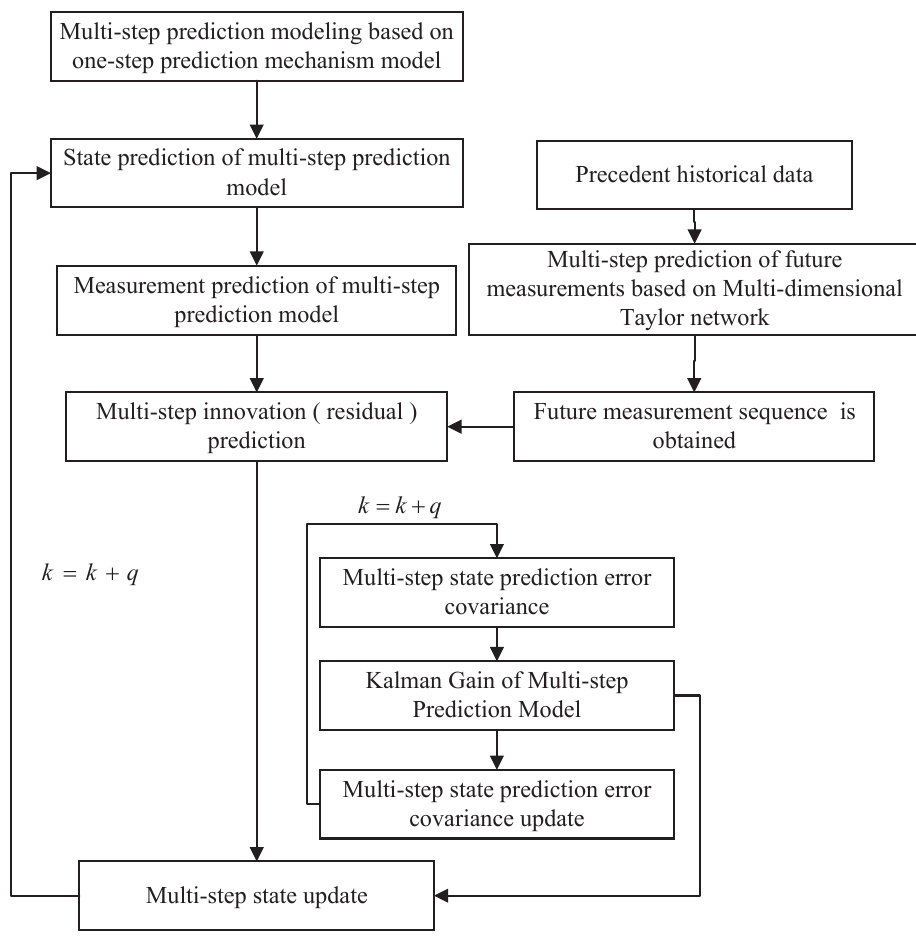
Figure 2. Flow chart of overall